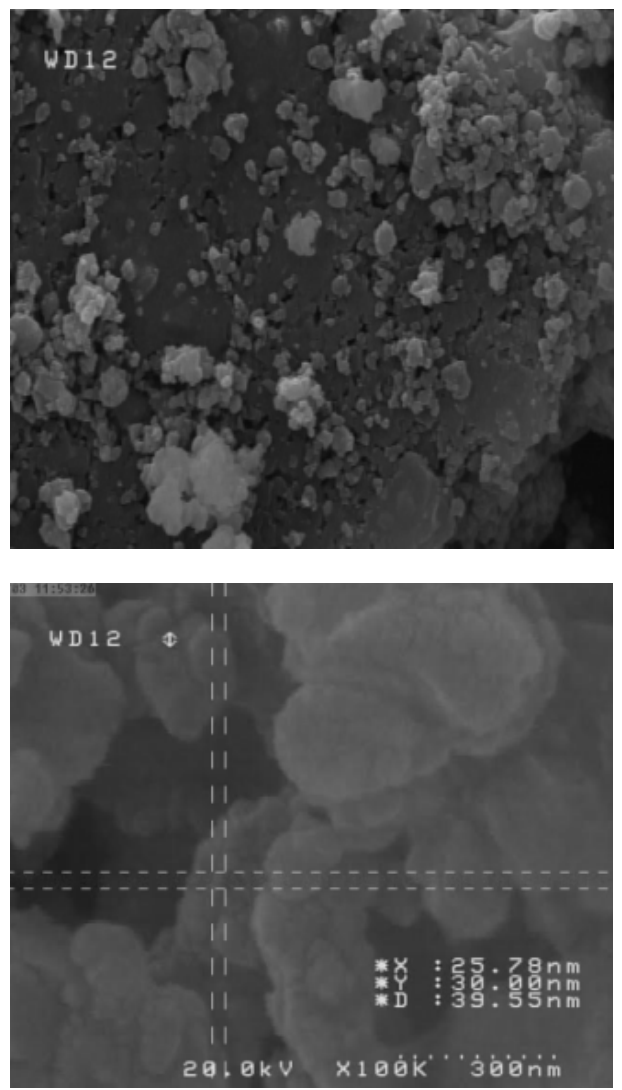
Fig. 10. SEM image of the synthesized perlite-SO